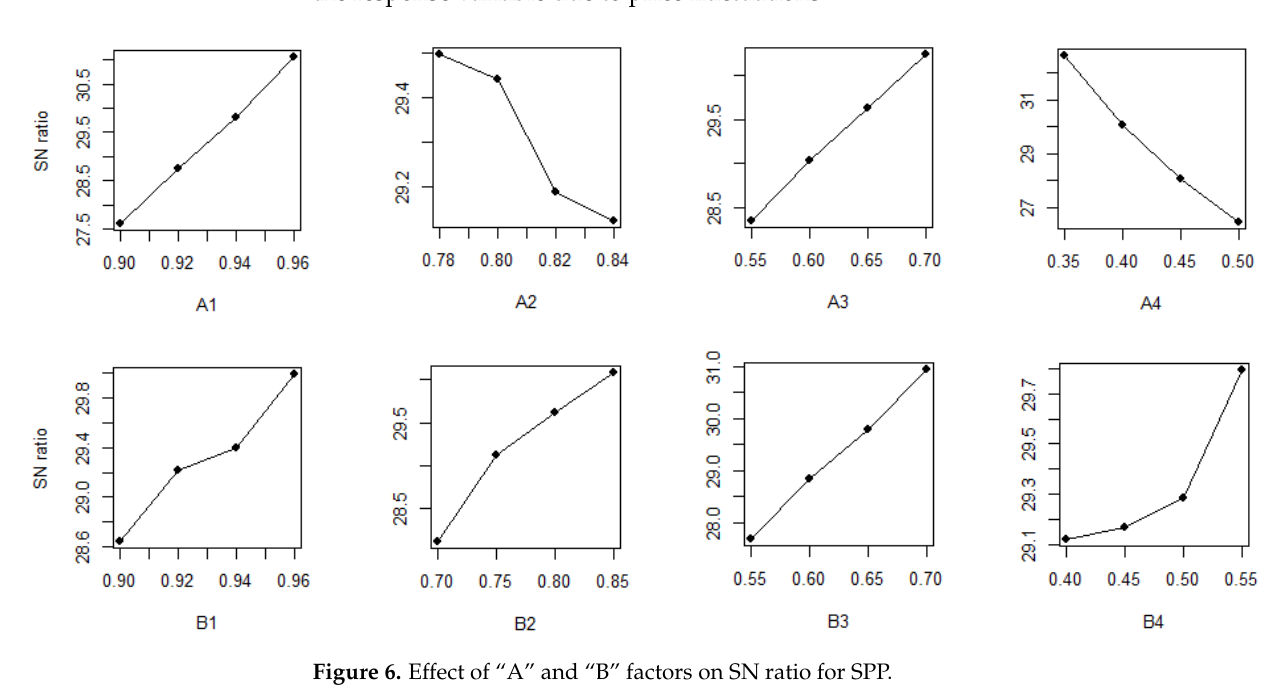
Figure 6. Effect of “A” and “B” factors on SN ratio for SPP.